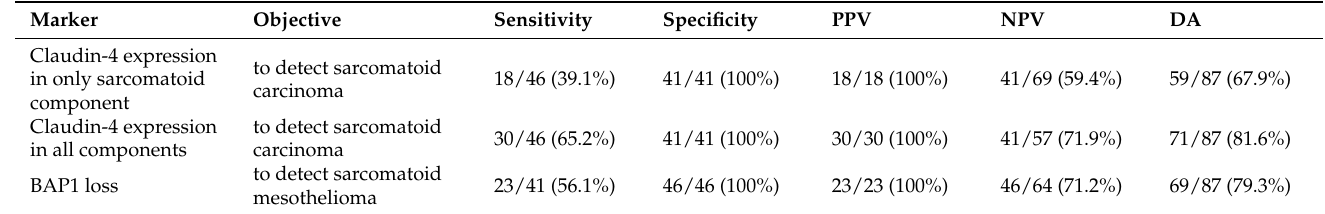
Table 3. Statistics of the Claudin-4 expression and the BAP1 loss to detect sarcomatoid carcinoma and sarcomatoid mesothelioma, respectively. The expression of Claudin-4 was evaluated in the sarcomatous component only and in both components (sarcomatous and epithelial). Legend : PPV, positive predictive value; NPV, negative predictive value; DA, diagnostic